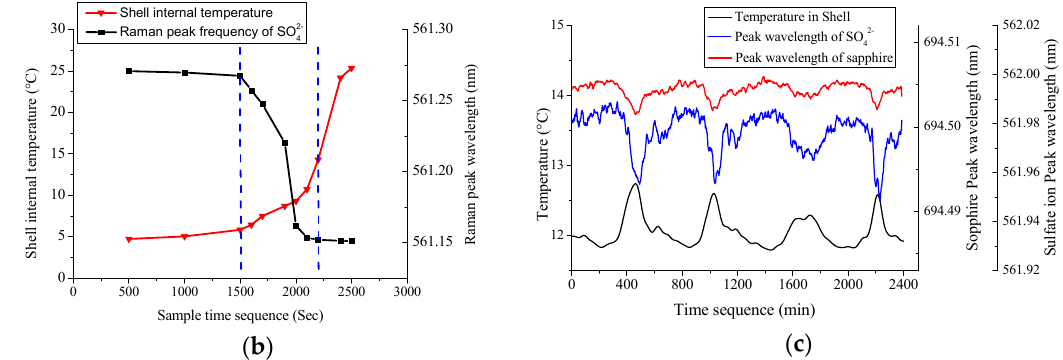
Figure 4. Effect of cabin temperature on Raman spectrum data. ( a ) Typical Raman spectrum and substance peaks. ( b ) Development trend of cabin temperature and SO 42 − Raman peak frequency (DOCARS system, #52 floating process). ( c ) Development trend among cabin temperature, Raman peak wavelength of sulfate ion and sapphire (OUC-Raman instrumental node).